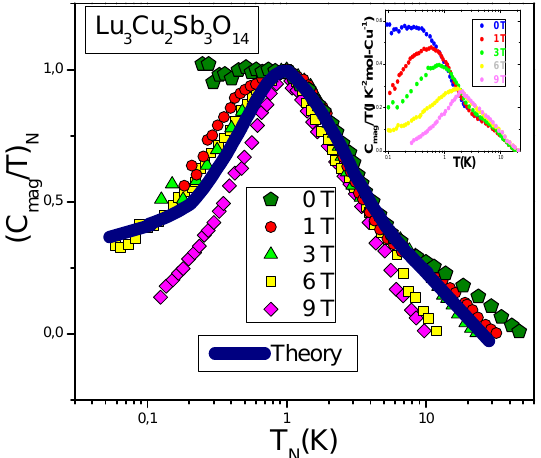
Figure 1. The normalized specific heat ( C mag / T ) N as a function of the normalized temperature T N measured under the application of magnetic field is shown in the legend. The normalized specific heat C mag / T is extracted from the measurement of the specific heat of Lu 3 Cu 2 Sb 3 O 14 [23] shown in the inset. The solid orange curve displaces the theoretical calculations based on Equation (3) [45]. The same curve is shown in Figures 2 and 3, exhibiting the scaling of the thermodynamic properties of the quantum spin liquid of Lu 3 Cu 2 Sb 3 O 14 .